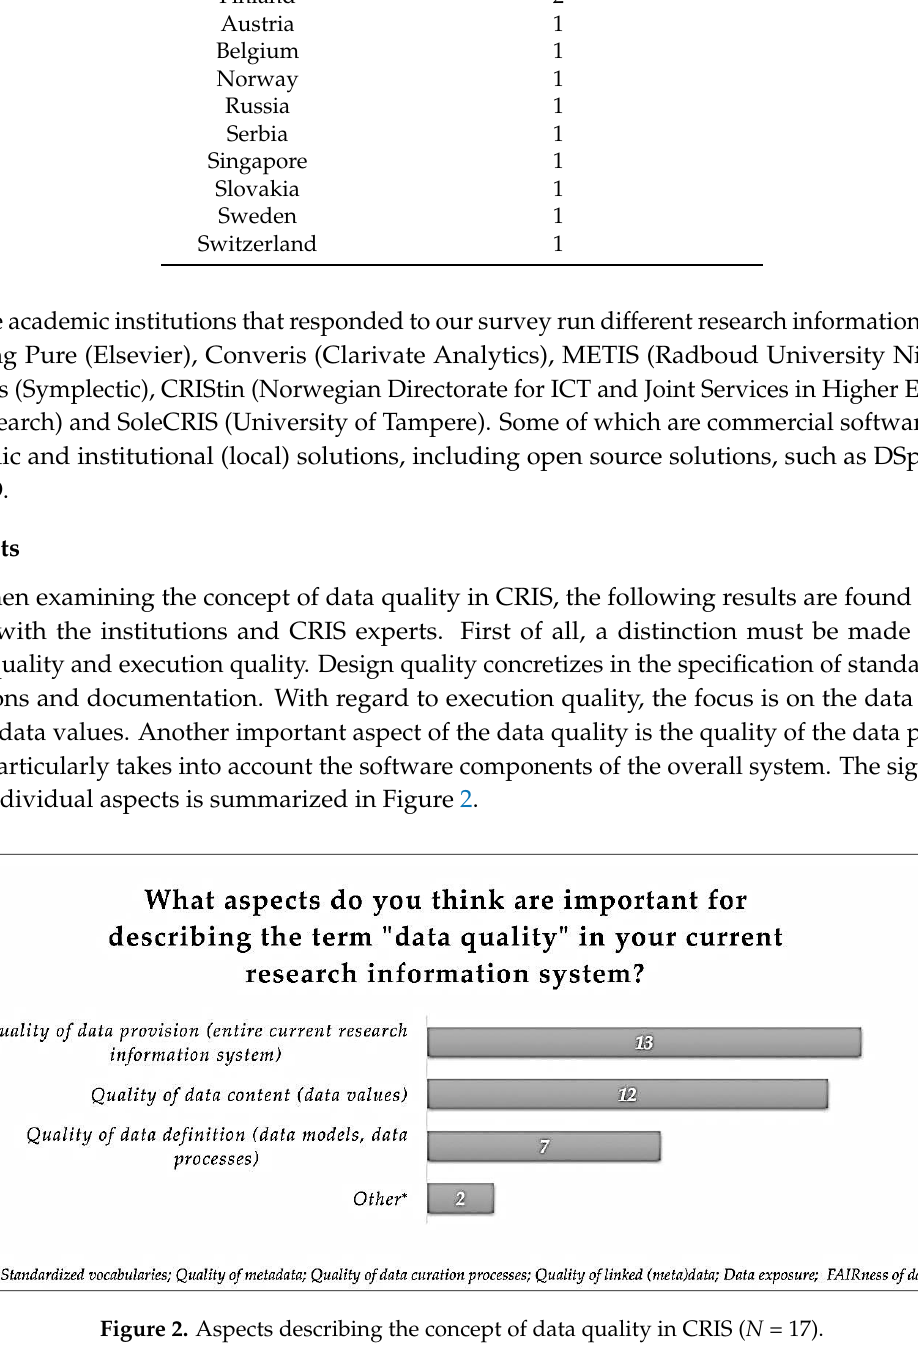
Figure 2. Aspects describing the concept of data quality in CRIS ( N = 17 ).